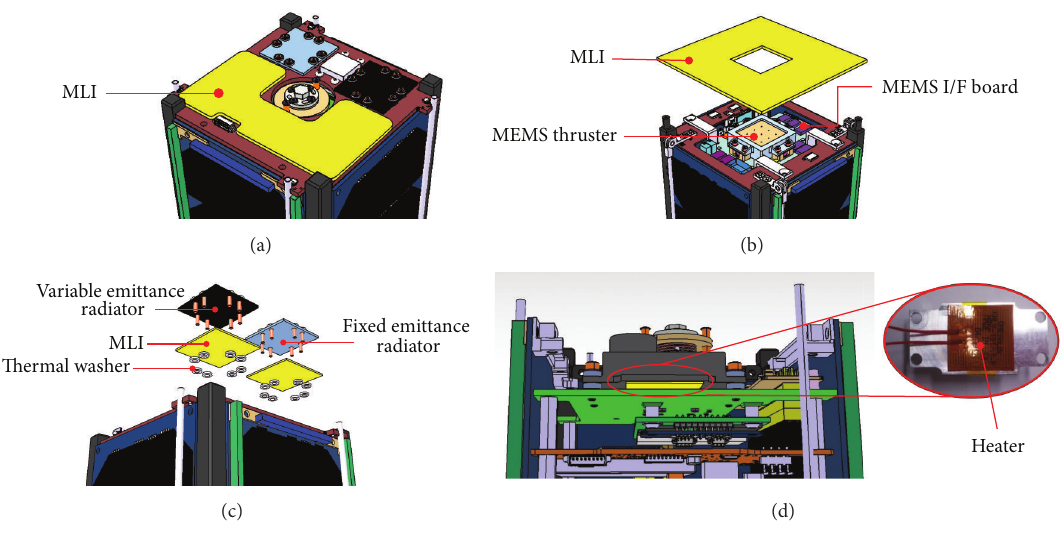
Figure 7: Accommodation of thermal control hardware.